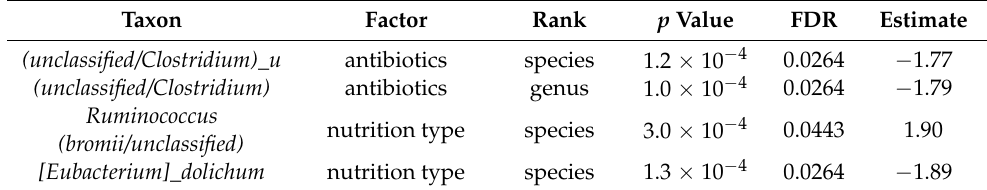
Table 4. Significant associations between microbiome profiles and therapy in the CCI patients. Taxon